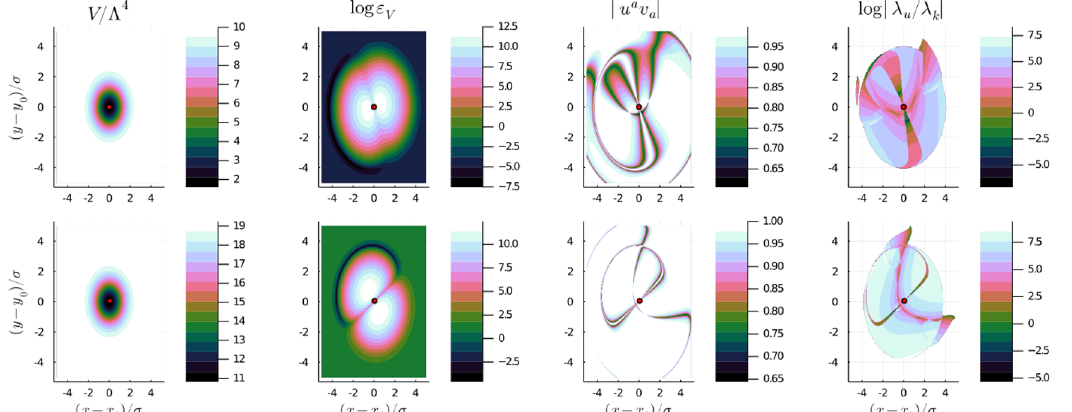
Figure 1 . The potential in (4.10), plotted over x and y at constant z = 0 . 5 M Pl , centered on the helical track. The red point marks this potential’s known high-turning solution. We show parameter sets 1 and 2 in the top and bottom row respectively. In the second column from the right, we show the alignment of the Hessian with the potential gradient. In the rightmost column, we show the ratio of the aligned and orthogonal eigenvalues of the Hessian: parameter set 1 has substantially lower λ over much of the surveyed range. u /λ k